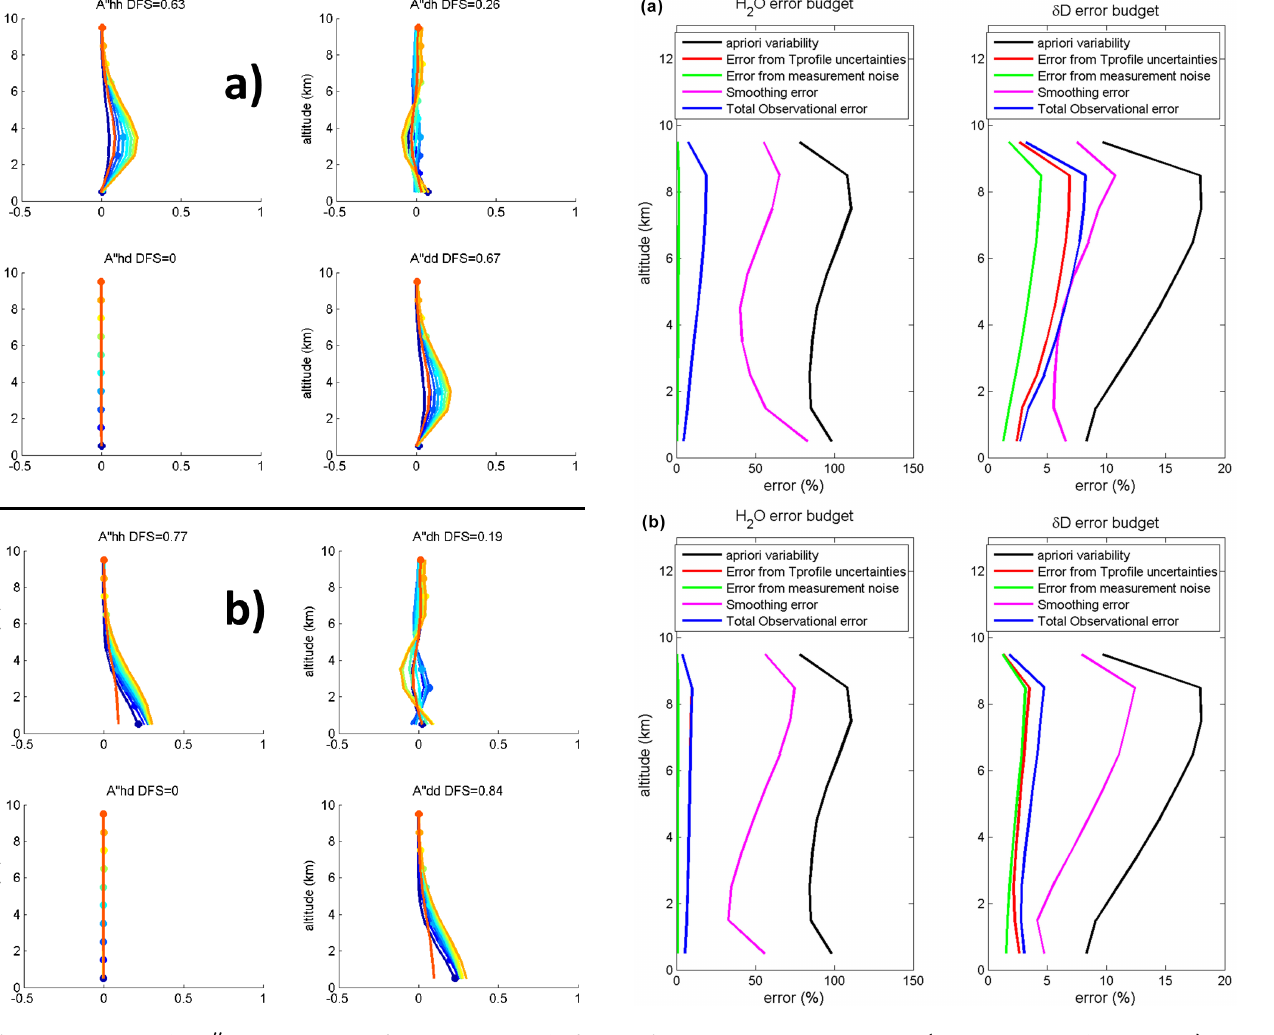
Figure 7. Mean error profiles (quadratic sum of covariance) for 2011 with | 1T | < 4K (a) and | 1T | > 8K (b) for air tempera- ture, measurement noise, smoothing, and the total observational q ( temperature 2 + measurement noise 2 ) , for H 2 O (left) and δ D (right) for the { humidity, proxy- δ D }